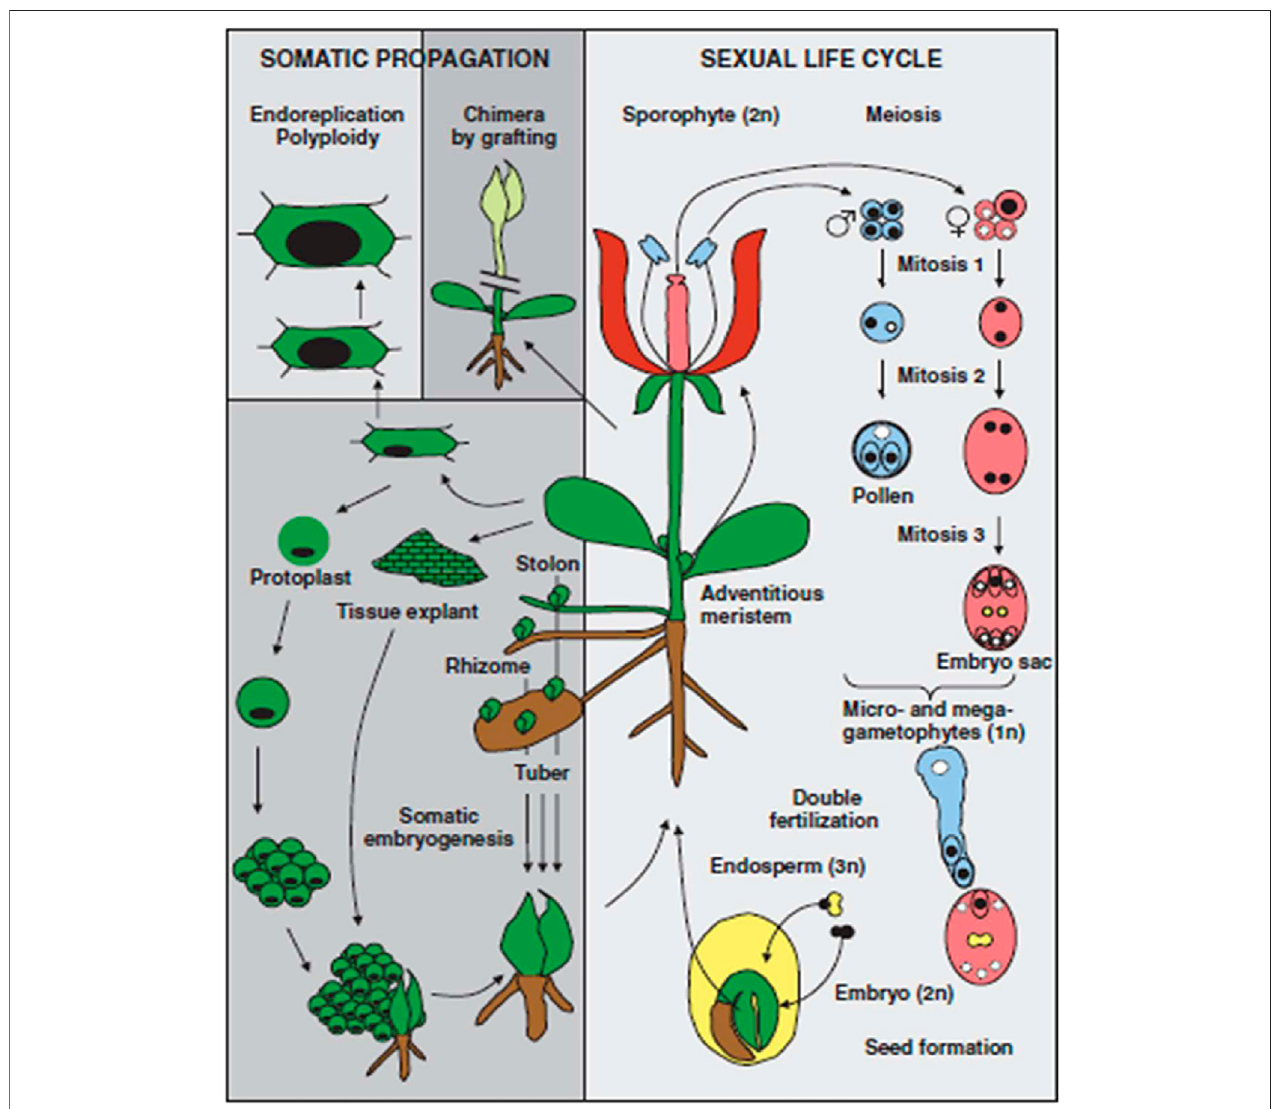
FIGURE 1 | Unique aspects of the plant life cycle (Reproduced from Pikaard and Mittelsten, 2014).